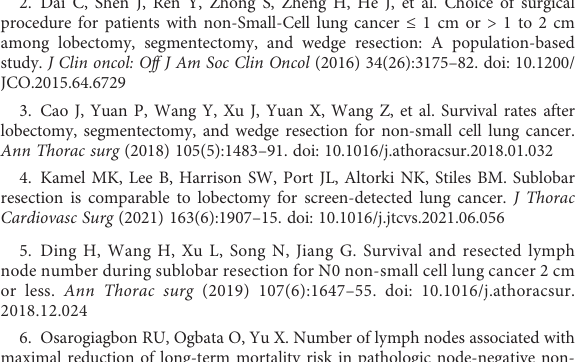
SUPPLEMENTARY FIGURE 1 Kaplan-Meier analysis of survival between wedge resection and lobectomy before matching. (A) Cause-speci fi c survival for non-small cell lung cancer (NSCLC) ≤ 1 cm; (B) overall survival for NSCLC ≤ 1 cm; (C) cause-speci fi c survival for NSCLC 1-2 cm; (D) overall survival for NSCLC 1-2